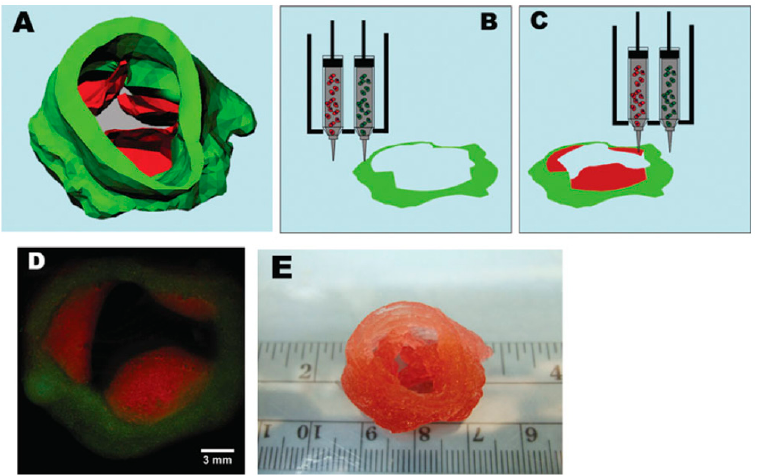
Figure 9. Bioprinting of aortic valve conduit: ( A ) aortic valve model based on micro-CT images. The root (green) and leaflet (red) regions were identified and rendered separately as 3D geometries, saved in STL format; ( B , C ) schematic illustrations of the bioprinting process with two different cell types and syringes; ( B ) root region of first layer of hydrogel embedded with SMC; ( C ) leaflet region of first layer obtained from VIC hydrogel; ( D ) fluorescent image of first two layers of aortic valve conduit; SMC for valve root shown in green and VIC for valve in red; ( E ) 3D bioprinted aortic valve conduit (Reprinted from Duan et al., 2013 [321] , with the permission of John Wiley & Sons Inc., published under license. Copyright © 2022 Wiley Periodicals Inc.).